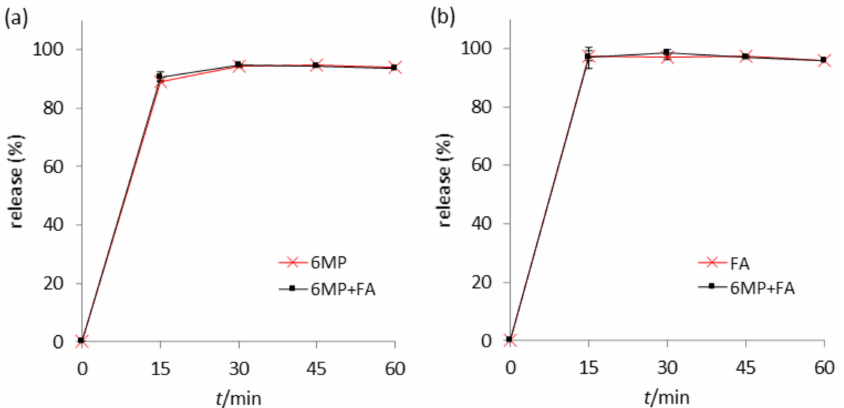
Figure 6. Dissolution profiles of ( a ) MP and ( b ) FA formulations subjected to the dissolution proce- dure individually and combined. Error bars represent the standard deviation ( n =